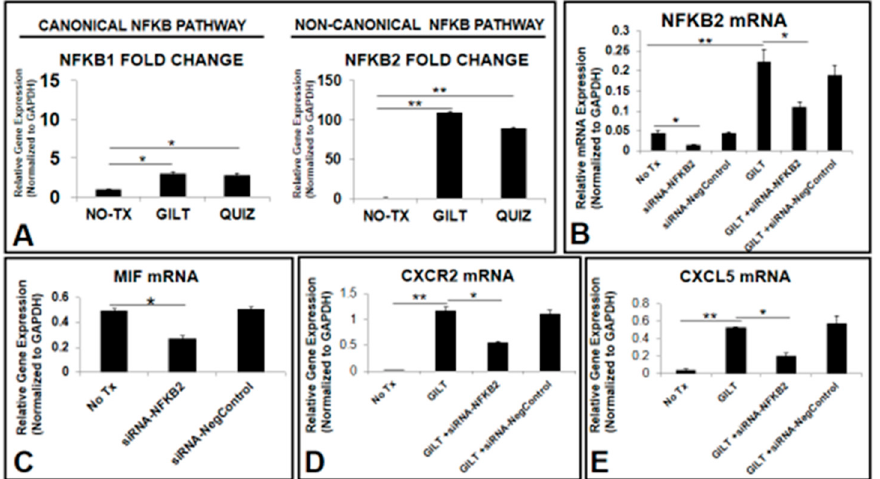
Figure 5. TKI-activated NFKB2 (P100/P52) pathway and siRNA knockdown of NFKB2 in vitro. ( A ) Data show mRNA expressions of canonical ( NFKB1 ) and non-canonical ( NFKB2 ) pathways after 80 nM GILT or 80 nM QUIZ treatment; ( B ) 2 days after the siRNA-NFKB2 treatment (50 nM) with or without 80 nM GILT in vitro, the cells were collected for RNA isolation and gene expressions were analyzed by qPCR. Data show mRNA expressions of NFKB2 ; ( N = 3) ( C – E ) Data show mRNA expressions of MIF , CXCR2 and CXCL5 genes after transiently knocking down NFKB2 in MV4-11; * p < 0.05, ** p <